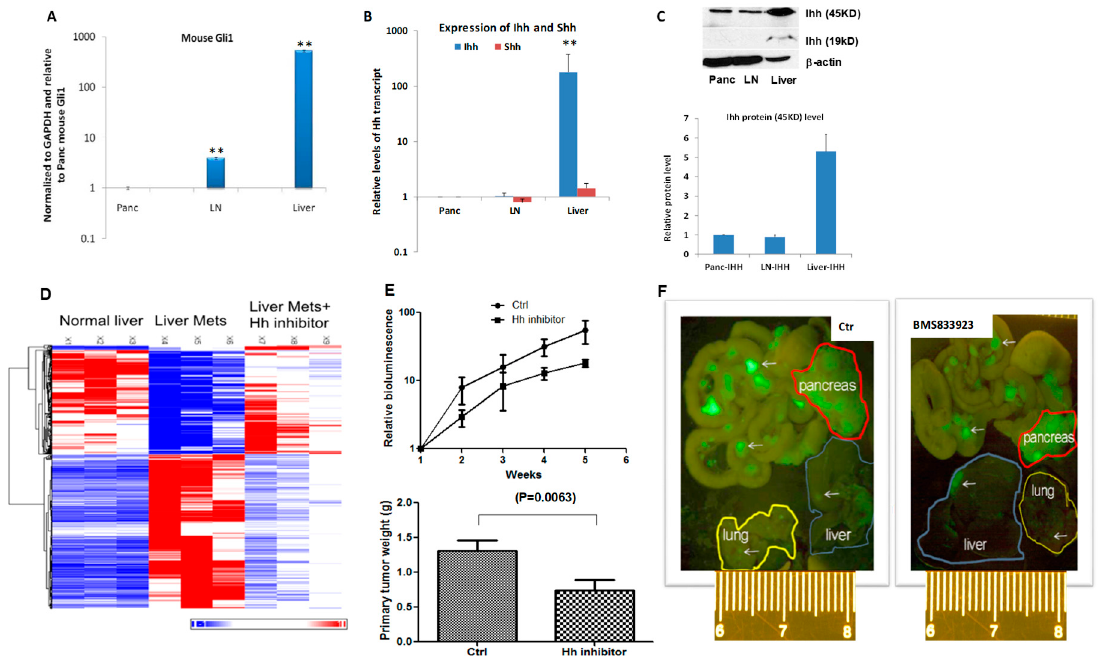
Figure 1. Activated hedgehog signaling in orthotopic mouse models of pancreatic cancer metastasis. ( A ) Expression of mouse Gli1 gene, an indicator for hedgehog signaling activity, in tumor-bearing pancreatic tissues, metastatic lymph nodes and liver, was detected by Taqman-based real-time PCR analysis. ** p < 0.005 by Student t -test of two independent means ( n = 5/group). ( B ) The transcript levels of SHH and IHH in different tissues were detected by real-time PCR (Taqman-based) ** p < 0.005 by Student t -test of two independent means ( n = 5/group). ( C ) Western blotting analysis of IHH protein levels in tumors of pancreas, lymph nodes and liver. Metastatic nodules were dissected (based on GFP-expression) from liver tissues for protein analysis to reduce the Ihh protein level from the tumor microenvironment. We performed protein analysis from three independent mice with liver metastases and three normal liver tissues with similar results. ( D ) The effect of smoothened inhibitor BMS833923 on liver gene expression patterns in MIA PaCa2-based orthotopic mouse model was shown following RNA sequencing analyses. While metastatic liver tissues have a very different gene expression pattern from naïve liver tissues, addition of BMS833923 every the other day for 3 weeks altered the gene expression pattern to reassemble that of naïve liver tissues. ( E ) The effect of smoothened inhibitor BMS833923 on pancreatic cancer growth was revealed by weekly with bioluminescent intensity from the cancer cells as well as the tumor weight difference after the mice were sacrificed. Five mice per group were used in this experiment (with power 95% alpha error 0.05). ( F ) Whole body imaging detection of GFP expression pancreatic cancer cells in pancreas, lymph nodes, lung and liver in MIA Paca2-based orthotopic mouse model following administration of BMS833923 or with vehicle control. White arrows indicate the site of pancreatic cancer cells (GFP positive). Scale bar: centimeter. Similar results were also observed in AsPC1-based orthotopic mouse model (Figure S4 and S5).